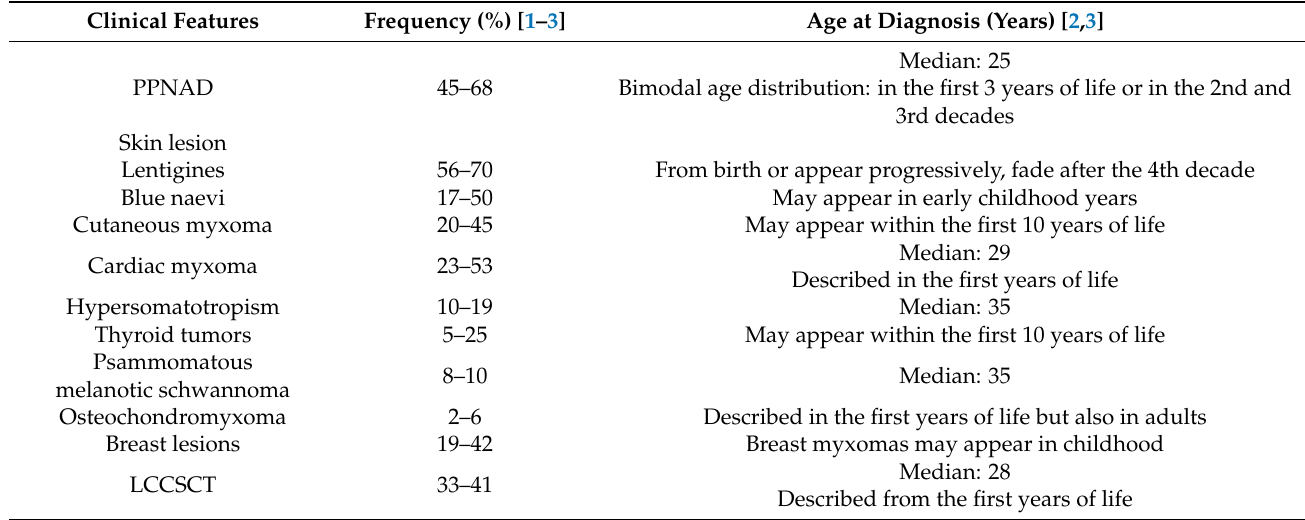
Table 2. Manifestations of Carney